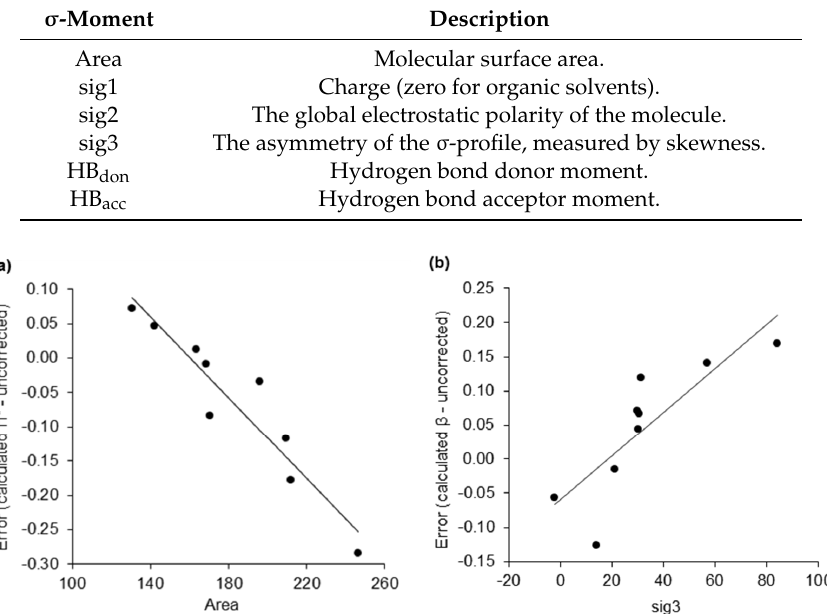
Figure 4. Error correction for the calculated KAT parameters of acyclic ethers as linear functions of σ - moments. ( a ) Calculated π * error correction; ( b ) Calculated β error correction. σ -moments. ( a ) Calculated π * error correction; ( b ) Calculated β error